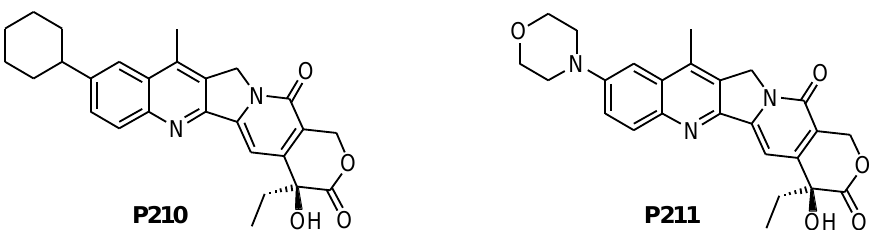
Figure 5. The CPT analogues discussed in this study.